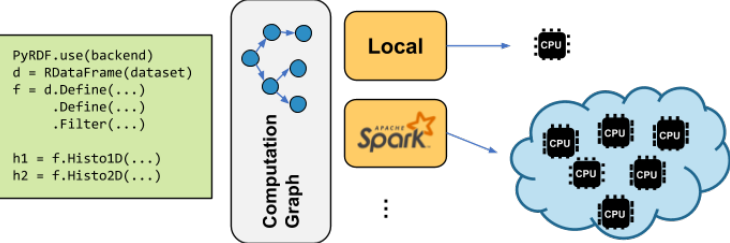
Figure 3: PyRDF workflow. From left to right: The user code gives input to create a com- putation graph, which is then either executed locally or sent to a distributed environment, according to the user’s